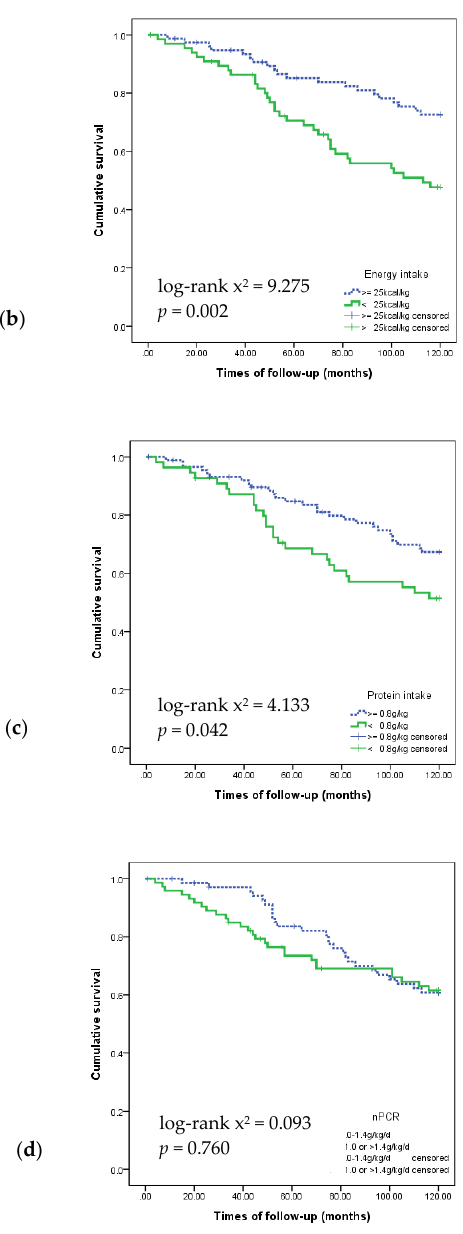
Figure 1. Kaplan–Meier survival curves showing 120-month survival according to nutritional markers: ( a ) Malnutrition Inflammation Score; ( b ) energy intake; ( c ) protein intake; and ( d ) nPCR.